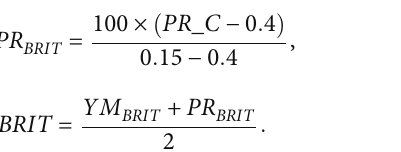
Figure 2: Frequency diagram of natural fracture spacing observed in Chang 6